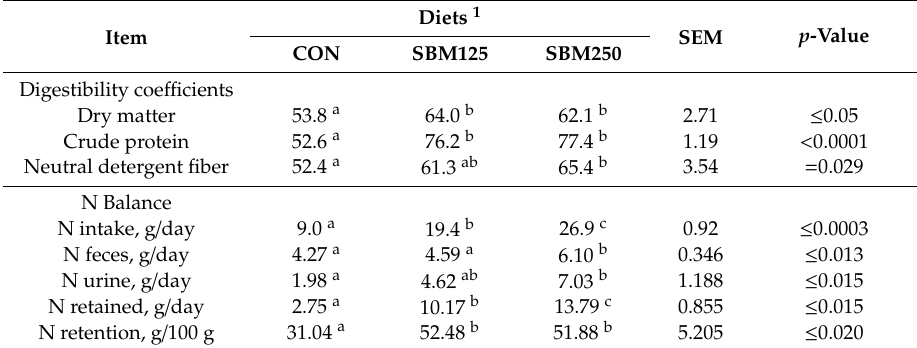
Table 2. E ff ect of protein supplementation on nutrient digestibility and N balance of Awassi lambs fed low-quality